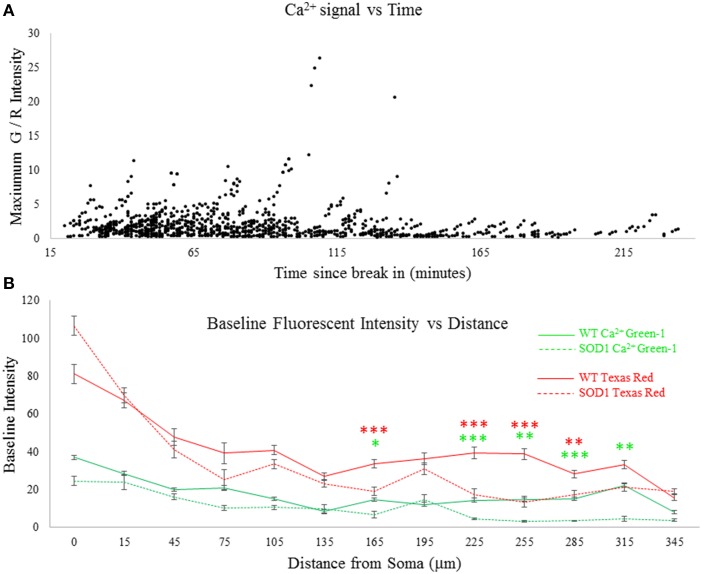
Assessment of time and dye filling. Patch electrodes with Ca2+ green-1 dextran and Texas red dextran in the internal solution filled motoneurons beginning at the time of break-in (marking the start of whole cell patch configuration). (A) Stimulation-evoked Ca2+ signal over time. There was a significant drop in the Ca2+ signal over time (p = 0.000), which was eliminated by excluding data past 120 min (p = 0.550). (B) Baseline fluorescence (without stimulation) was measured throughout all processes of all cells recorded. Fluorescent intensity in WT motoneurons is shown in solid lines and SOD1 in dotted lines. Significantly lower levels of both dyes are observed in SOD1 motoneurons in some dendritic compartments, suggesting impaired diffusion. Error bars = ±SEM, T-tests were used with post-hoc Bonferroni corrected multiple comparisons tests between WT and SOD1 for each fluorophore: *p < 0.05; **p < 0.01; ***p < 0.001.